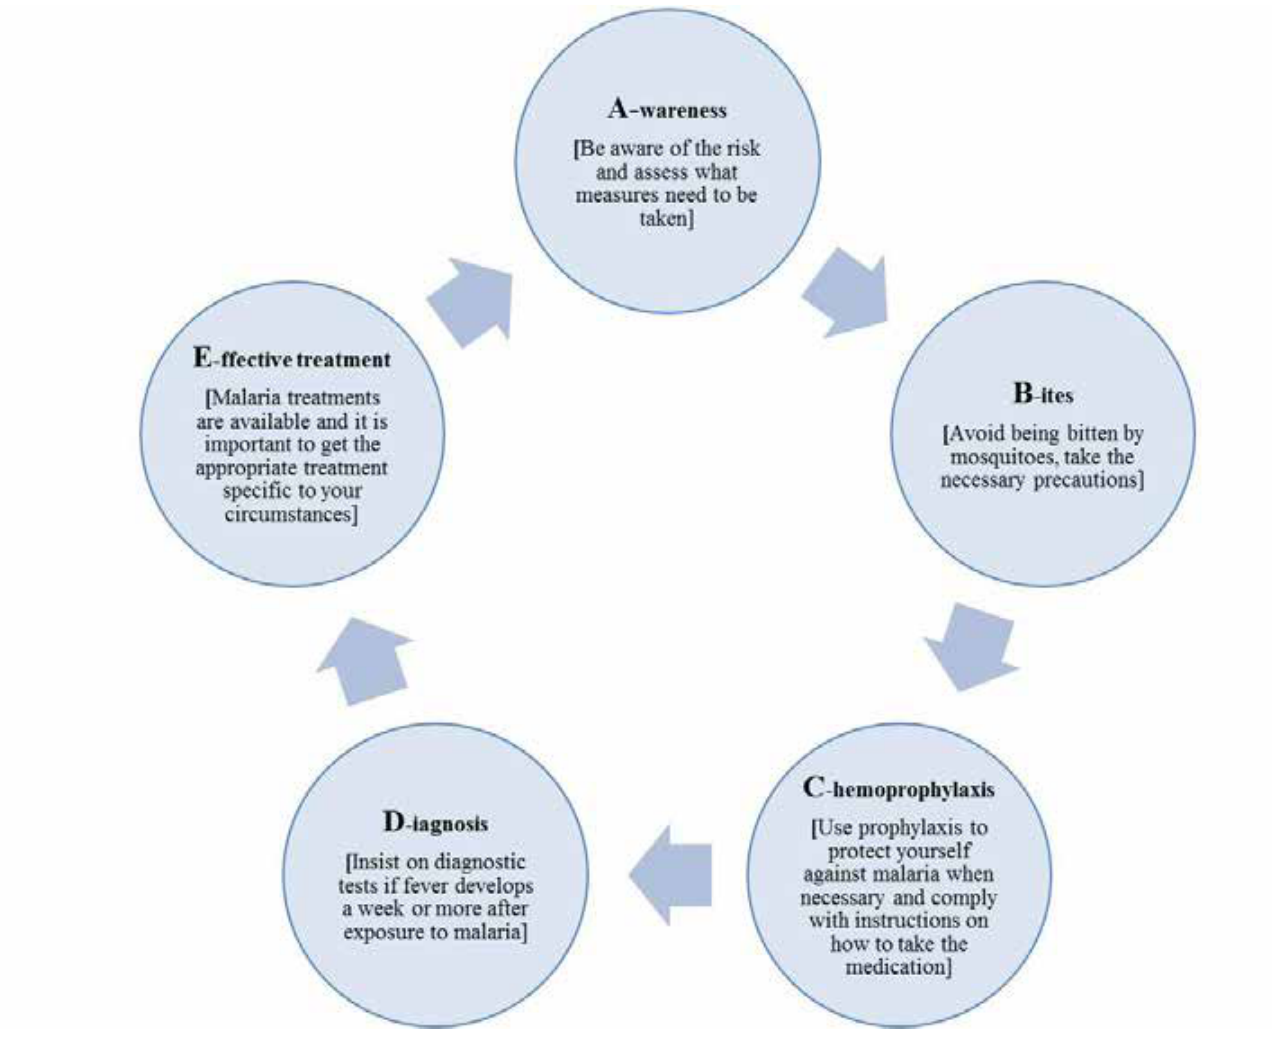
Figure 2: The ‘ABC’ of malaria prevention.